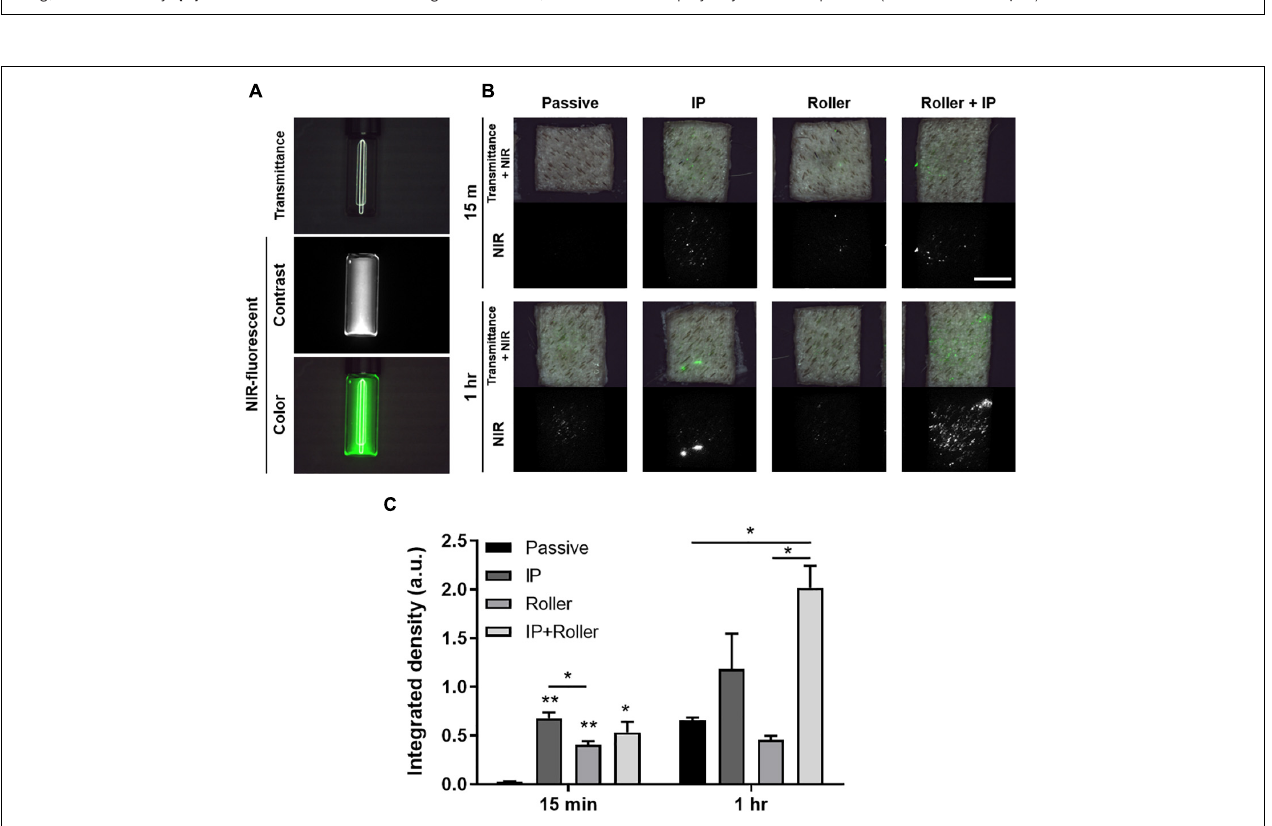
FIGURE 8 | Ex vivo transdermal delivery of NIR dye-labeled SF. (A) The NIR dye, ZW800-1C-NHS-ester, was conjugated with proteins in the secretome. (B) Macroscopic visualization of transport of secretome into the ex vivo porcine skin with the assistance of physical penetration enhancers (PPEs). (C) The quantification data based on the FLARE images indicated the combinatorial application of IP and roller enhanced the transport of secretome transdermally (* p < 0.05; ** p < 0.01) (Scale bar = 1 cm).